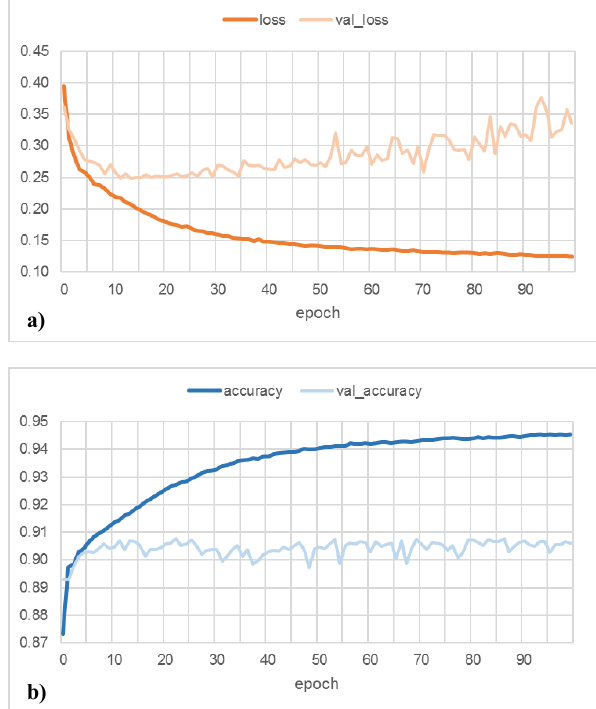
Figure 3. Evaluation of the model trained on U-Net architecture. (a) The Loss. b) The overall accuracy.